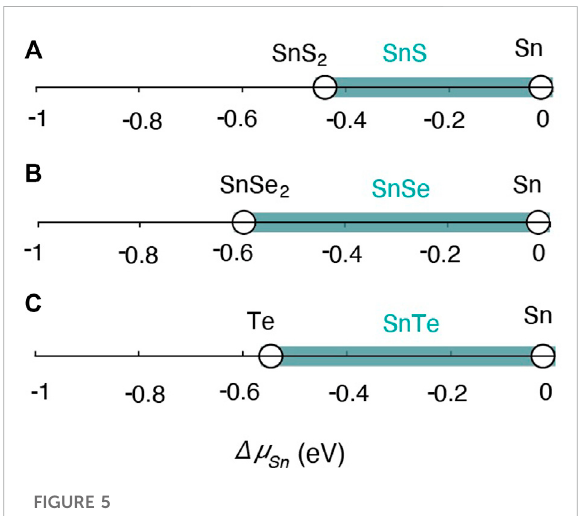
FIGURE 5 Phase stability regions for Orthorhombic (A) SnS ( Pnma ), (B) SnSe ( Pnma ) and rock salt (C) SnTe ( Fm3m ) in chemical potential space (shaded teal region) with the limiting phases denoted (black